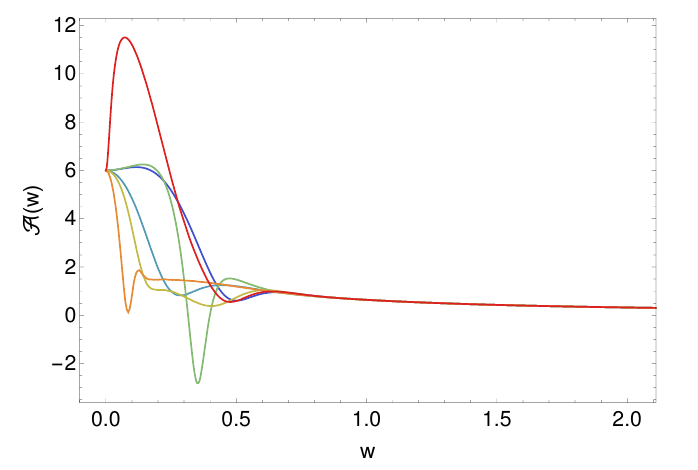
( w ) for six di ff erent initial configurations. The initial conditions all have Figure 1. The pressure anisotropy A the same value of the pressure anisotropy, but evolve di ff erently, which reflects the richness of the initial states. However at late times, for w > 0 . 7, all the curves behave identically and match the first order hydro prediction [2,